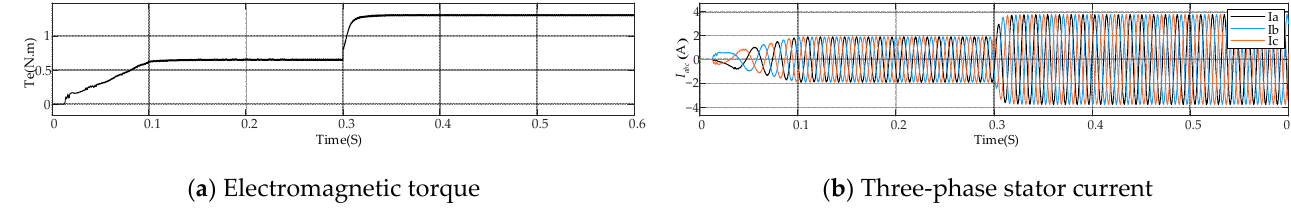
Figure 4. Electromagnetic torque and three-phase stator current curve.